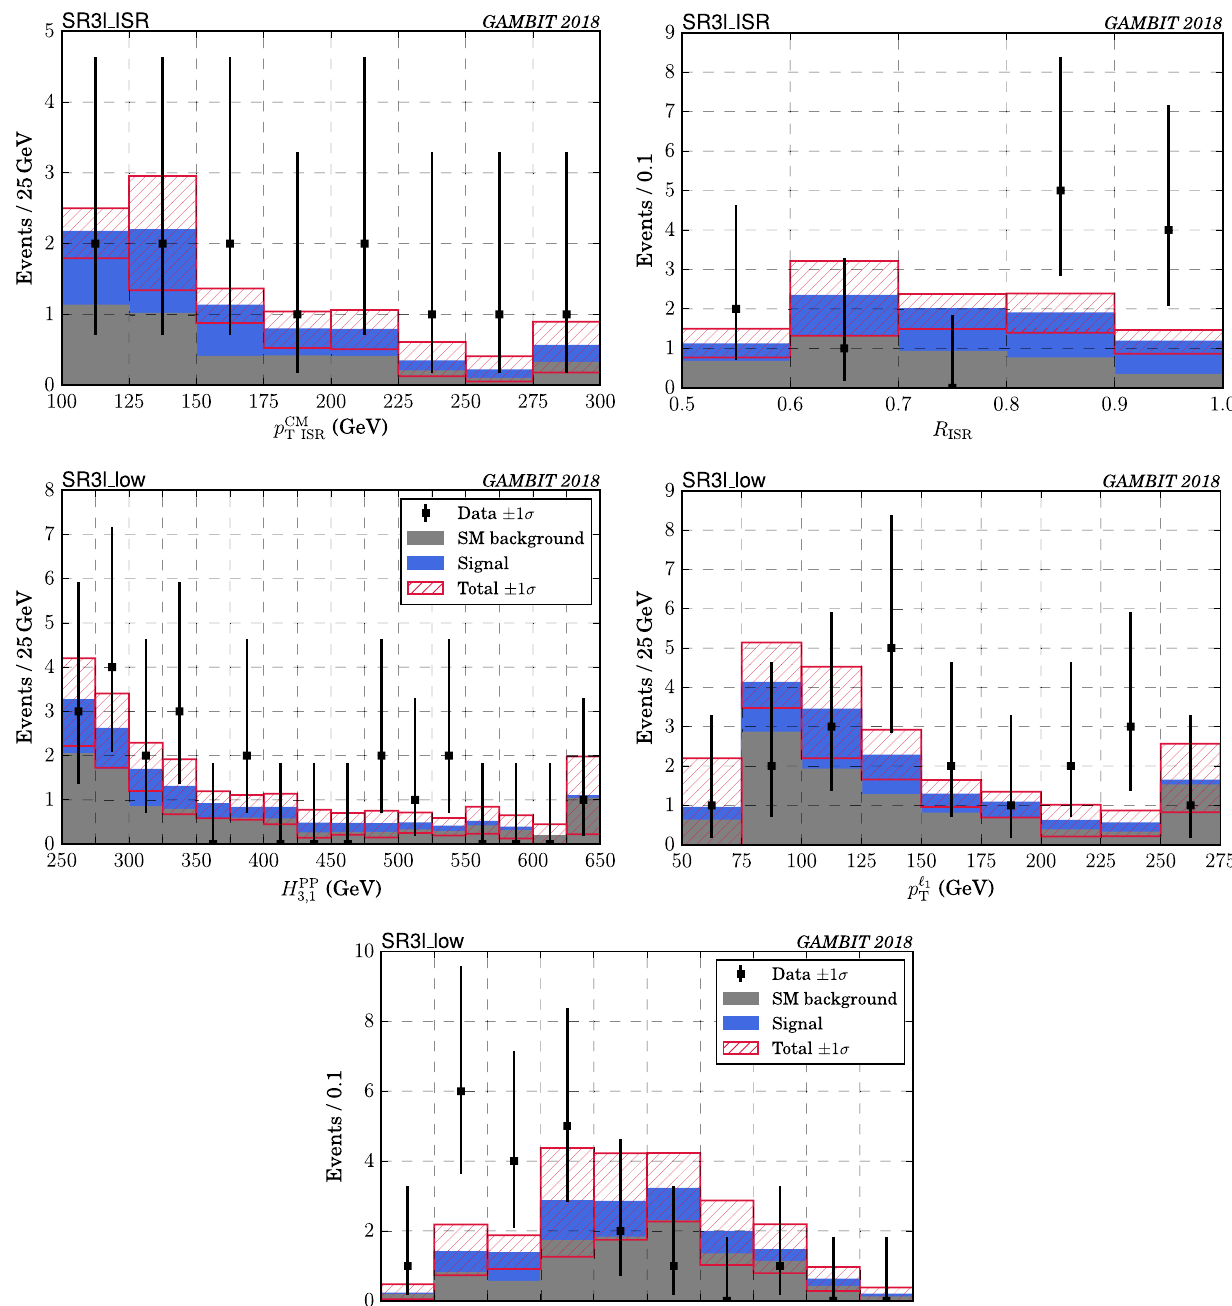
Fig. 23 Distribution of kinematic variables in the 3 lepton signal regions for the ATLAS RJ analysis, after applying all selection require- ments. The grey bars show the total SM background (taken from Ref. [117]) and the stacked blue bars show the signal for our best-fit point based on the combination of 8 and 13TeV data. The hatched red bands